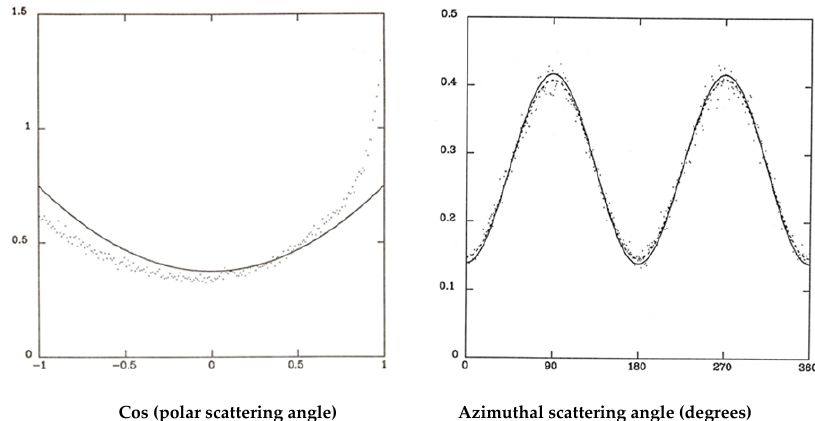
Figure 2. Solid lines are the Thomson approximation and the dots allow for coherent and incoherent scattering angles and photoelectric absorption for the lithium blocks. ( Left ) Cosine of the polar scattering angle; and ( right ) The azimuthal scattering angle.